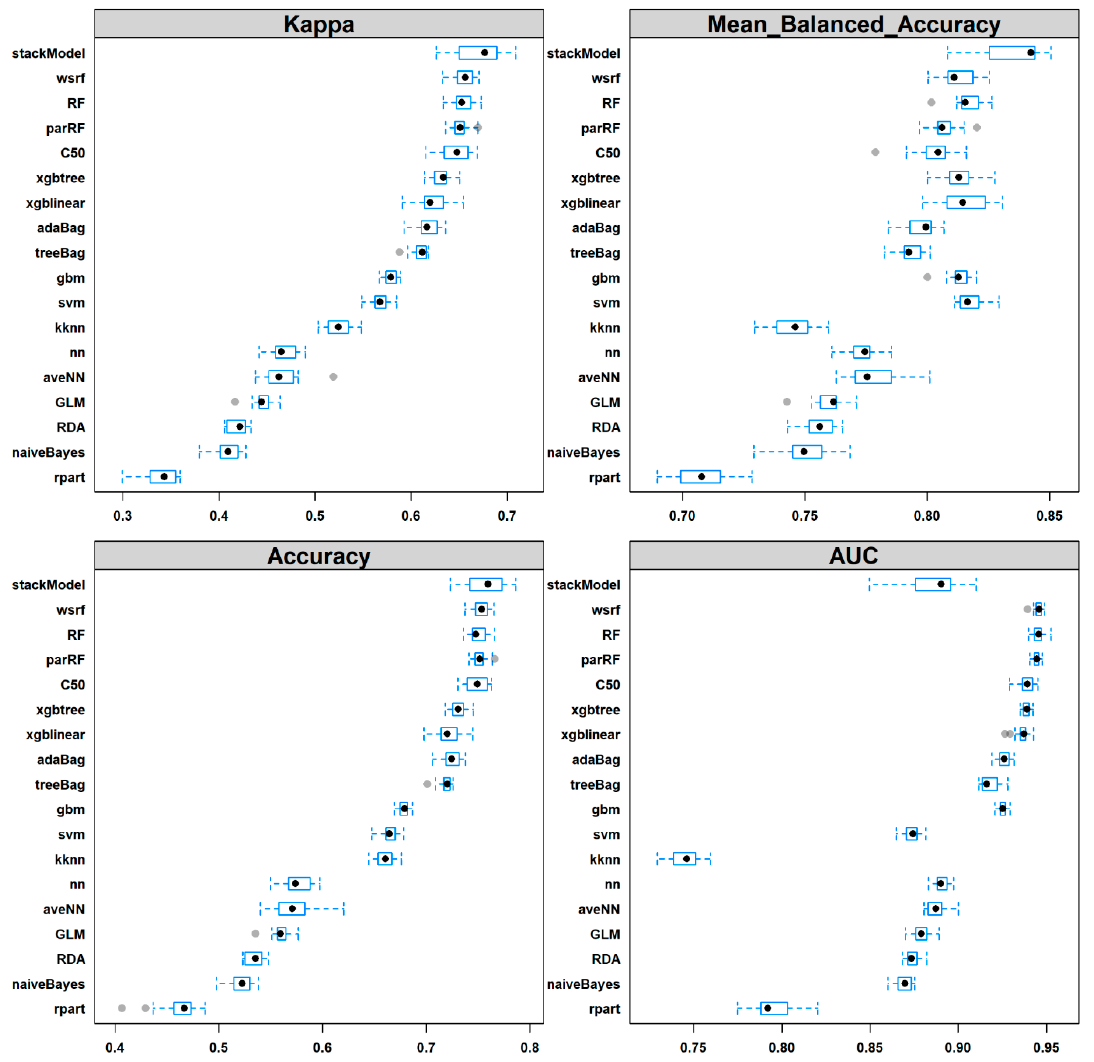
Figure 2. Training performance of the 18 machine learning models for wetland classification. Black dots are the mean value; box shows the 1st and 3rd quartiles; the dashed whiskers are the maximum and minimum values; grey dots are outliers based on the repeated-CV resampling. If there is no overlap of the quantile box, the di ff erence is statically significant. See Table 1 for classifier